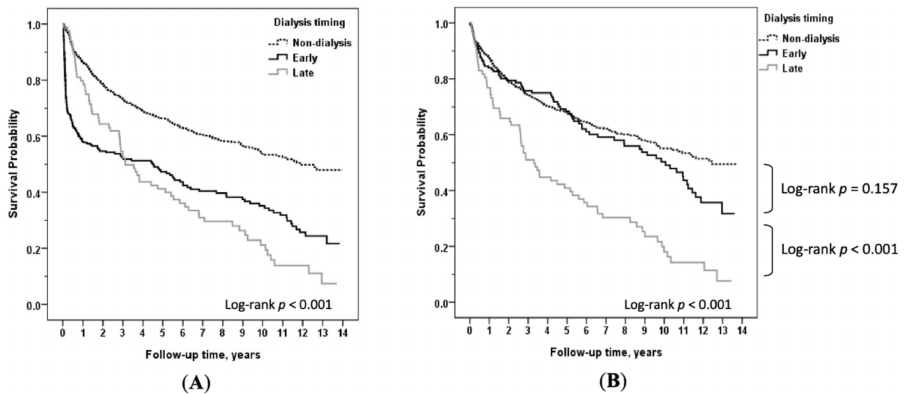
Figure 3. ( A ) Comparison of long-term survival among heart transplant recipients with non-dialysis versus early dialysis versus late dialysis; ( B ) among non-dialysis versus early dialysis versus late dialysis, conditional on survival to 3 months after heart